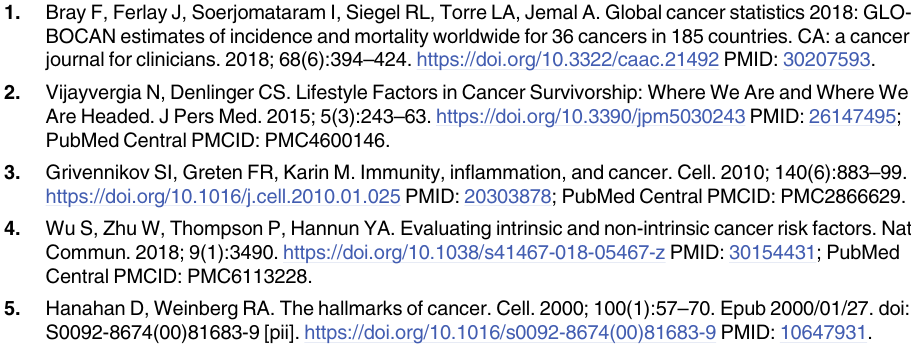
S1 Fig. Immunoblot analysis of the specificity of the ARF6 antibody. S2 Fig. DNA sequencing of the PCR product in Fig 1D and alignment of the sequence with Arf6 gene